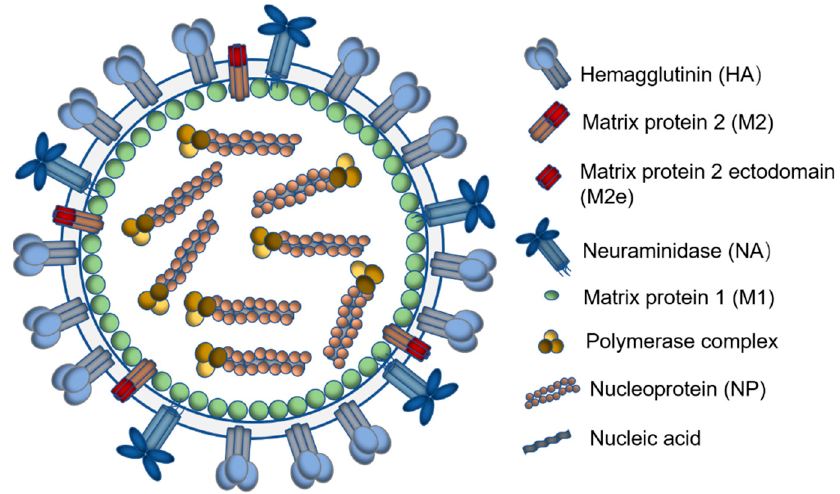
Figure 1. Schematic diagram of the influenza virus showing antigenic viral proteins.